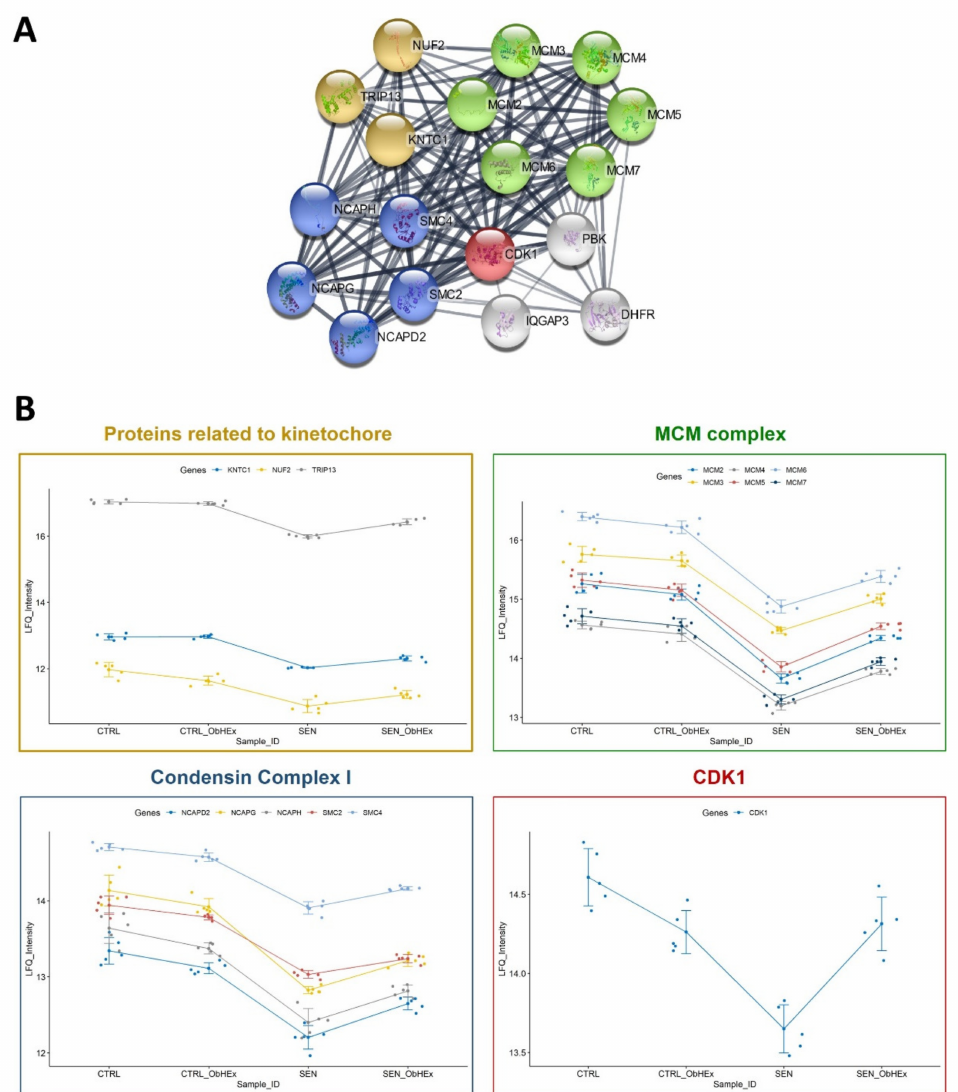
Figure 4. ( A ) Cluster analysis of upregulated proteins in senescent NHDF cells after ObHEx treatment. It was performed using the Cytoscape StringApp; setting 0.9 as the threshold (highest confidence). ( B ) Profile plots of the proteins included in the clusters reported in Panel ( A ). Each plot shows the mean LFQ intensity with error bars representing the error limits defined by the standard